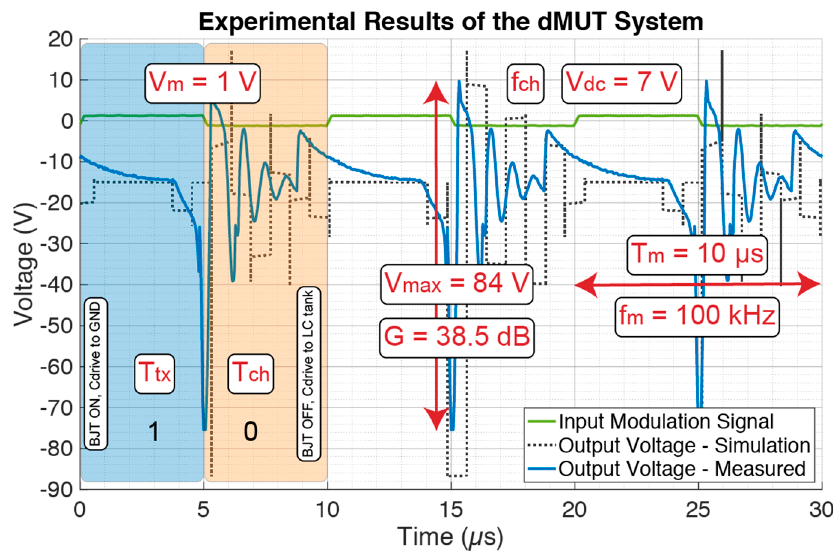
Figure 12. Experimental results of the dMUT system based on the parameters in Table 1 with the exception of the DC biasing voltage that was increased to V dc = 7 V for high performance application.